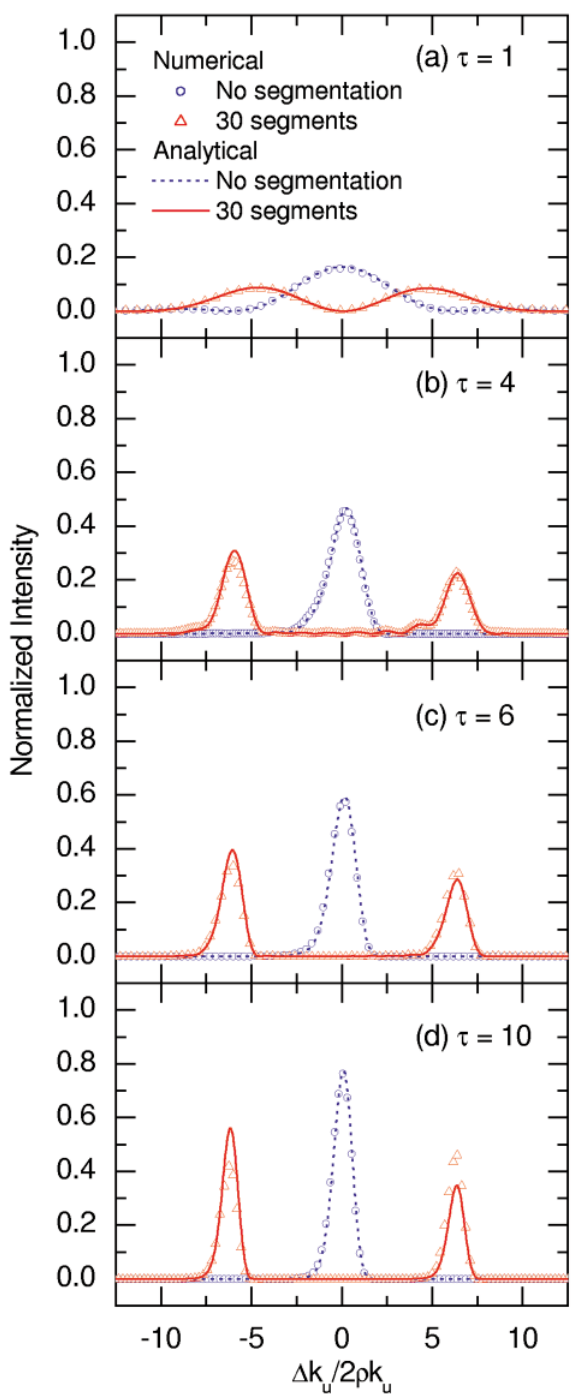
FIG. 4. (Color) Growth of radiation spectrum. The nor- malized spectrum is shown for different distances from the undulator entrance: (a) t (cid:1) 1 , (b) t (cid:1) 4 , (c) t (cid:1) 6 , and (d) t (cid:1) 10 . Two cases with no segmentation and 30 segments are shown.